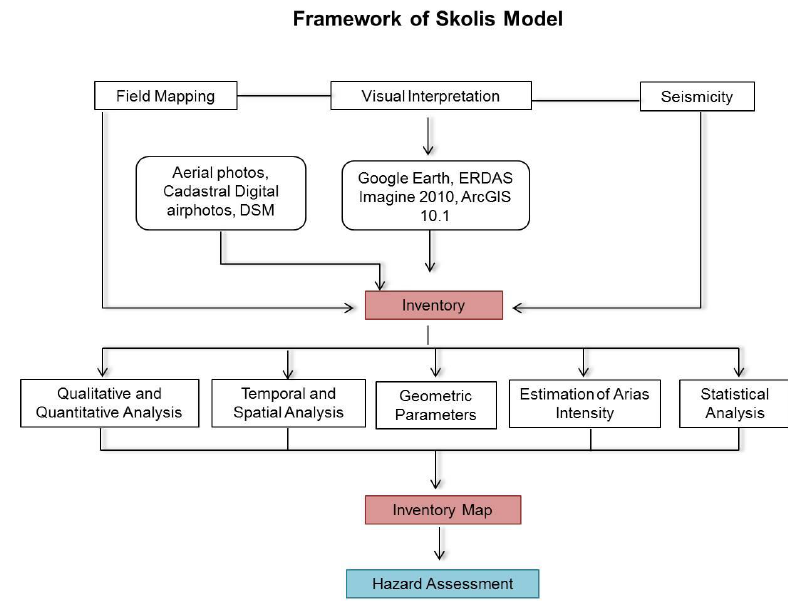
Figure 3. Flow chart that shows the steps of our methodology. ISPRS Int. J. Geo-Inf. 2020 , 9 , x FOR PEER REVIEW Overall, for the landslide inventory, we used ten (10) sets of remote sensing data. Geometric distortions, caused by viewing geometry and platform instability, are common in remotely sensed imagery. All aerial photographs were rthorectified to correct all possible geometric distortions following the methodology as described in Litoseliti et al. [40] and Koukouvelas et al. [29]. The digital orthomosaic and the digital surface model (DSM) from the National Greek Cadaster and Mapping Agency used as reference base maps for the selection of 84 ground control points for the orthorectification of all the other datasets. Table 1. Seismicity and spatial resolution of the analogue aerial photographs (AAP), digital aerial photographs (DAP), and satellite images (SI) datasets used and their sources. Orange color represent periods of available aerial photographs and light green the lack of aerial photographs.